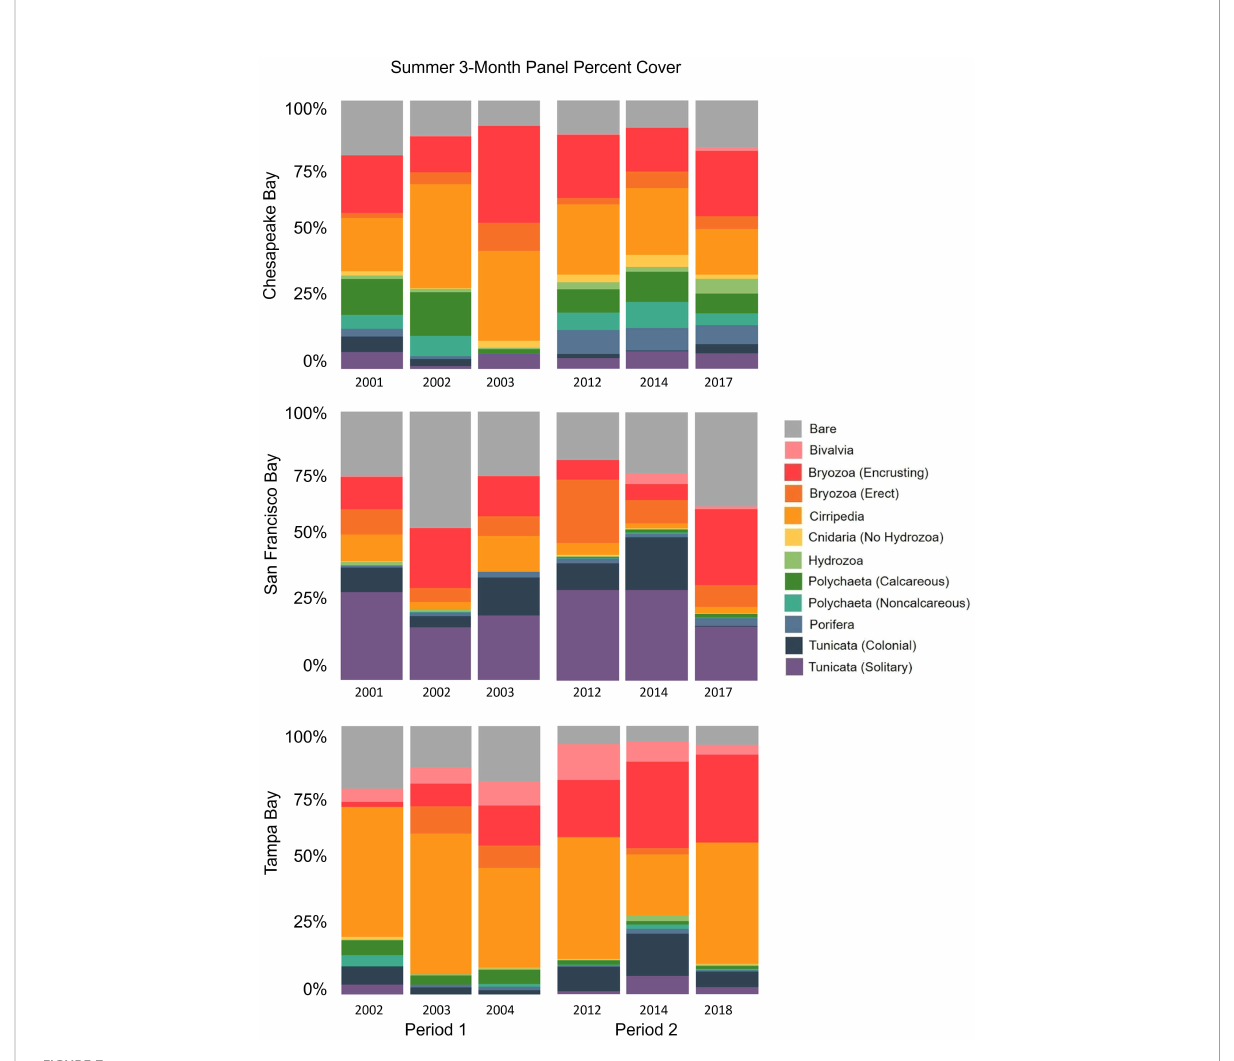
FIGURE 7 Total percent cover of major functional groups after 3-month summer deployment — comparing periods 1 and